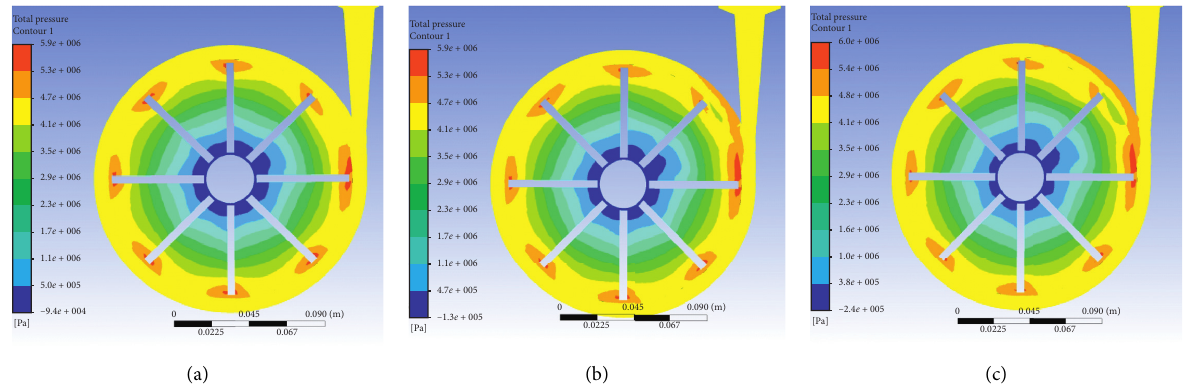
Figure 4: The total pressure distribution with inducer. (a) Q